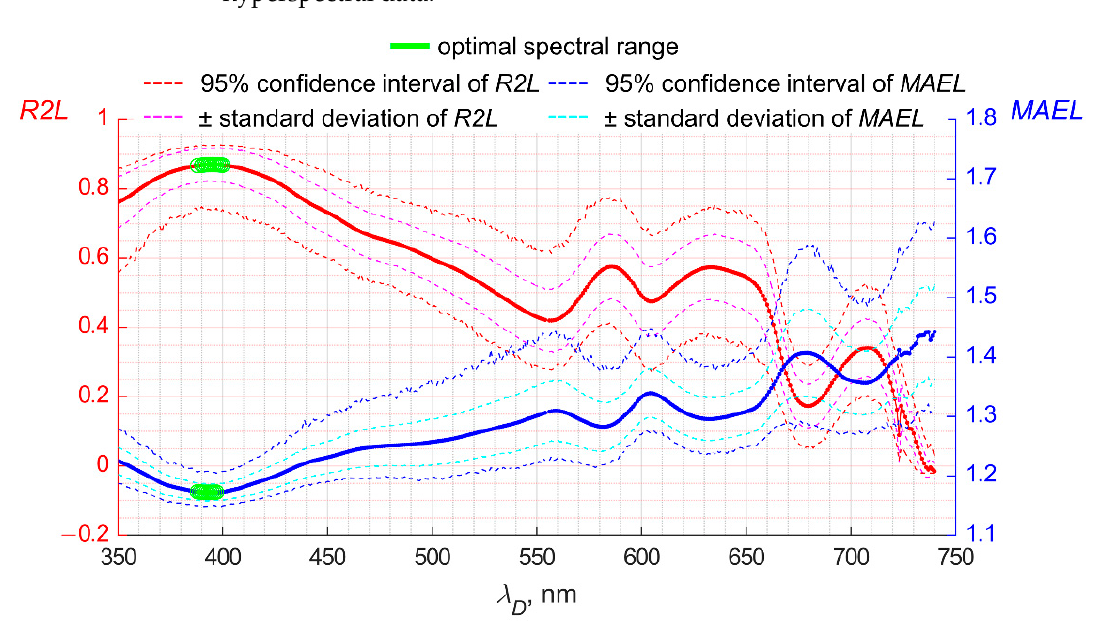
Figure 6. Spectral distribution of R2L and MAEL for the comparison of D ins and D rs calculated using Formula (9) from ASD hyperspectral data using R OC 2 ( λ D ) band ratio indices.